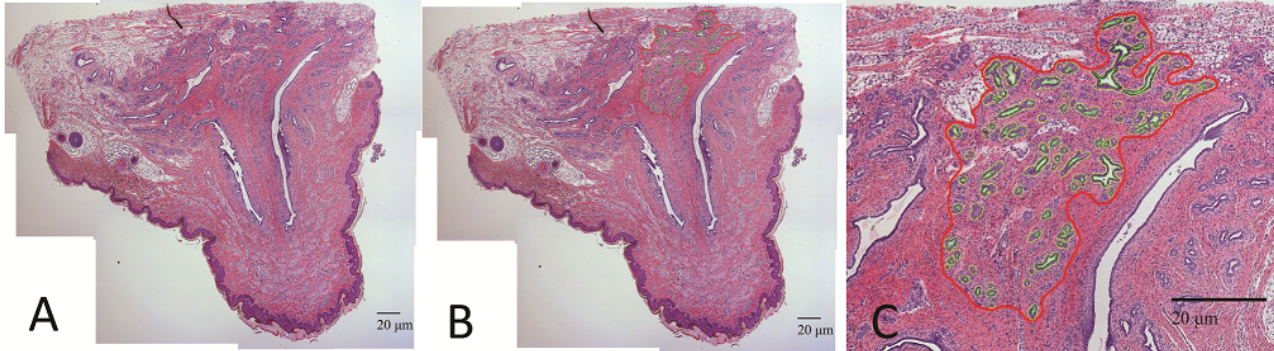
Figure 2. Histological section of teat and mammary tissue of 7-day postnatal gilt. ( A ) Teat and mammary tissue were excised from 7-day postnatal gilts, and images were captured at 200×. ( B , C ) Illustrate the selection of the mammary parenchymal area (red outline) and mammary epithelium (green outline) within this region for calculation of parenchymal epithelial area (PEA).